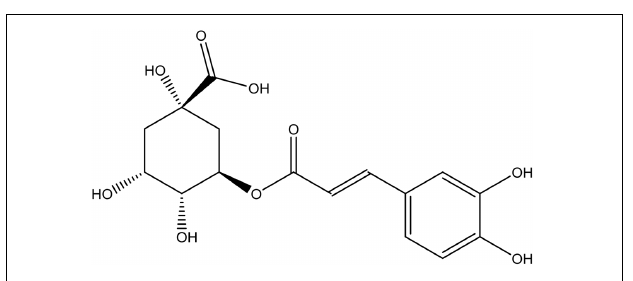
FIGURE 2 | The chemical structure of chlorogenic acid